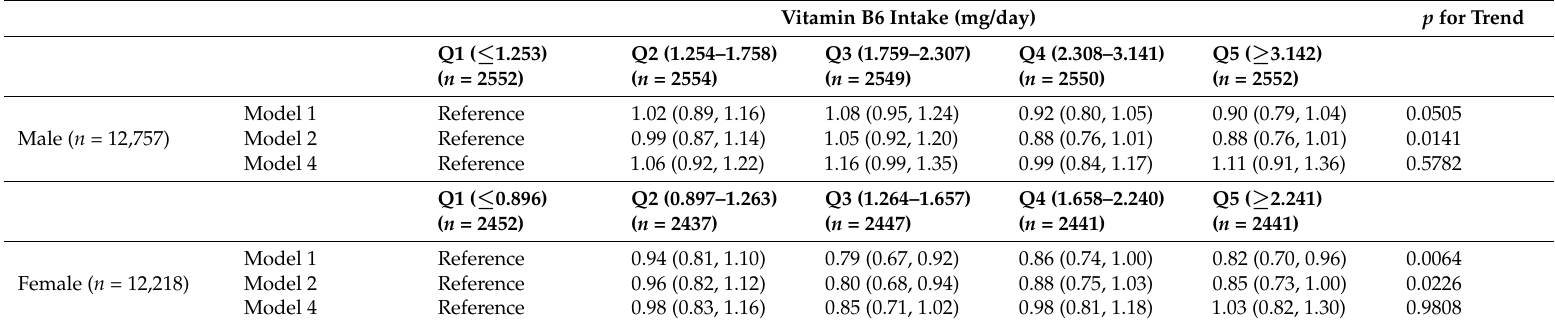
Table 5. Adjusted odds ratios of HU among participants associated with vitamin B6 intake.